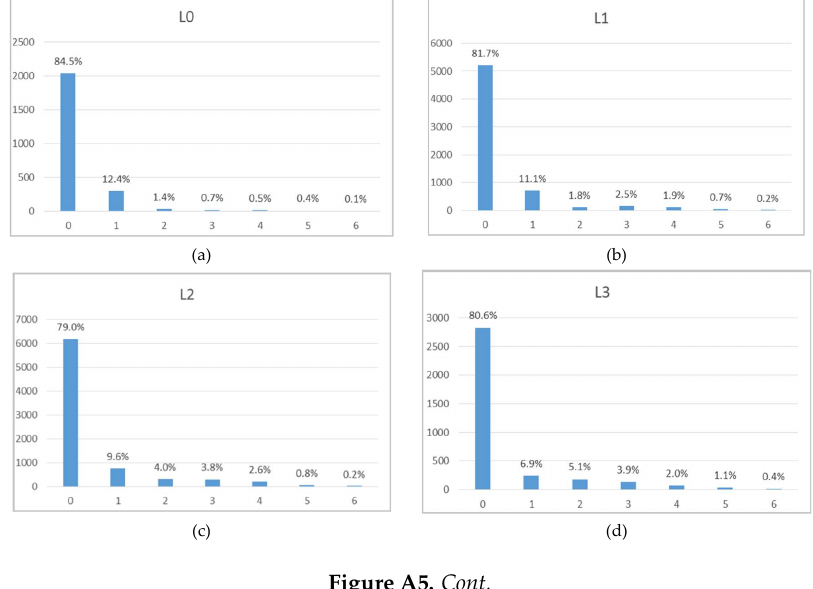
Figure A4. Cumulative histograms for borehole variables: (a) Vein thickness and (b) vein proportion.